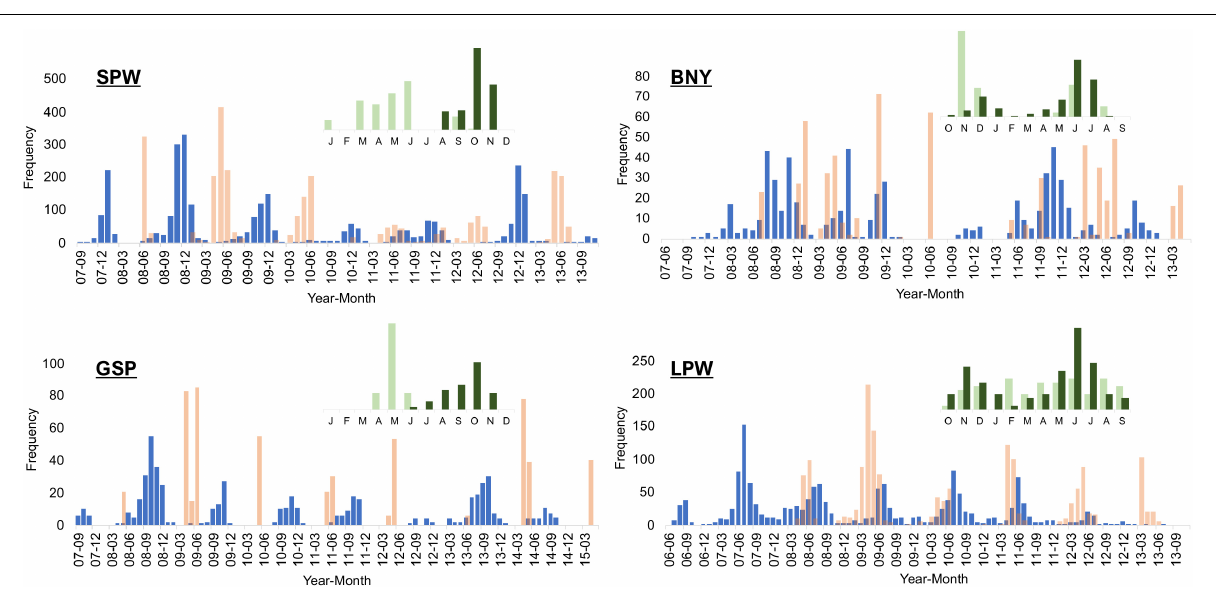
FIGURE 8 | Sample frequency (in pink bar) of the four flyingfishes and the frequency of the back-calculated hatch date (in blue bar) based on VBGM of the species, by year-month. Upper small panels are otolith sample month (light green) and back-calculated hatch month (dark green) from ring readings (starting from October for BNY and